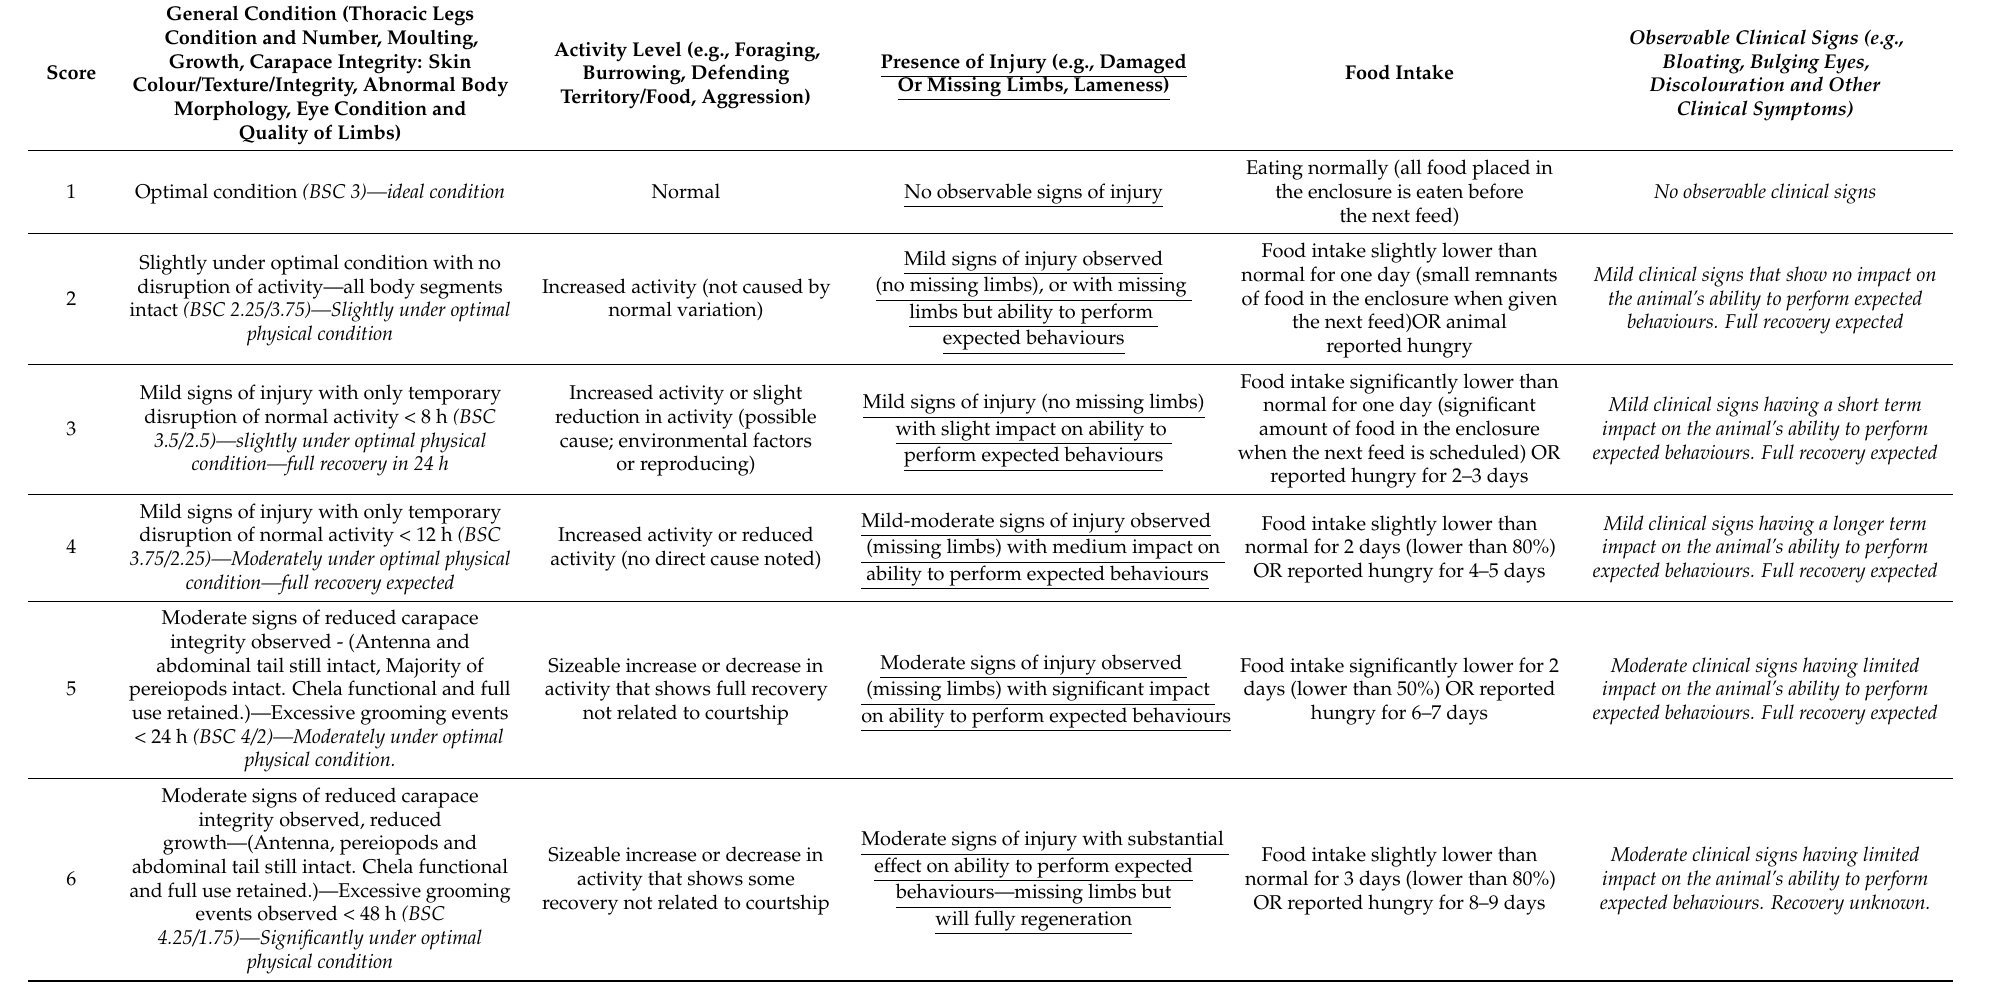
Table 1. Physical parameter scoring for the AWAG assessment (Underlined—factors only assessed in decapods, Italics—factors assessed in cephalopods